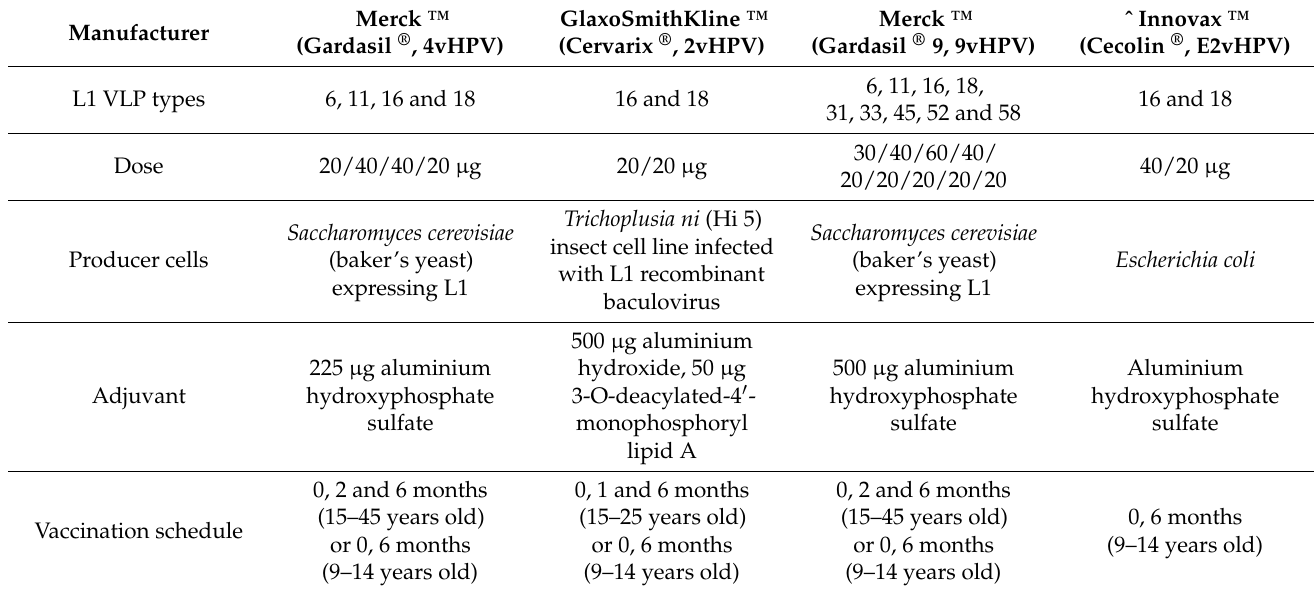
Table 5. Characteristics of HPV VLP